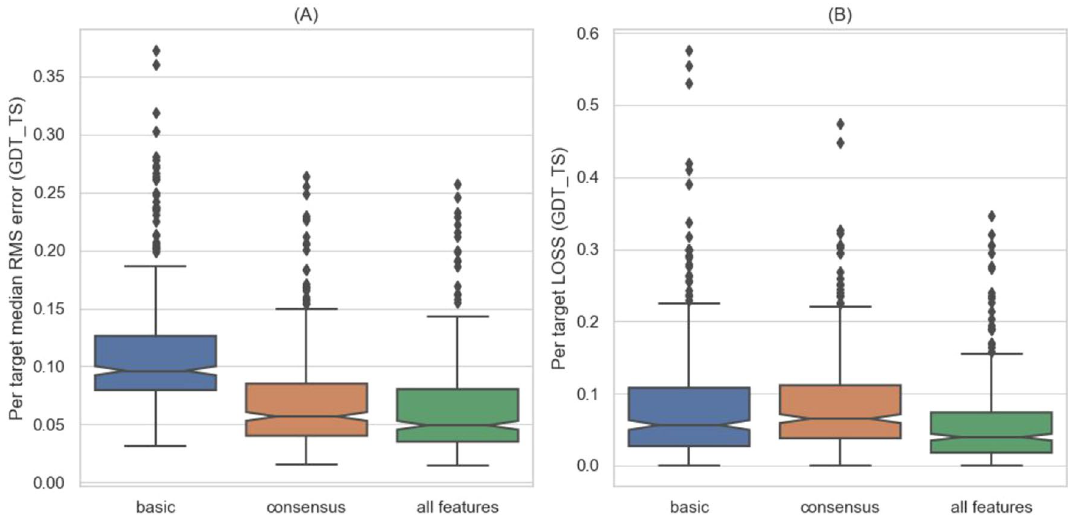
Figure 6. Per-target performance with different feature sets. The box plots show the per-target performance in terms of RMSE (A) and LOSS (B) , of Leave-One-Target-Out experiments with the basic features (blue), consensus features (orange), and all features (green). The differences between the median performances of all the features and the median performances of the feature subsets are statistically significant (Wilcoxon one-sided test with a p-value